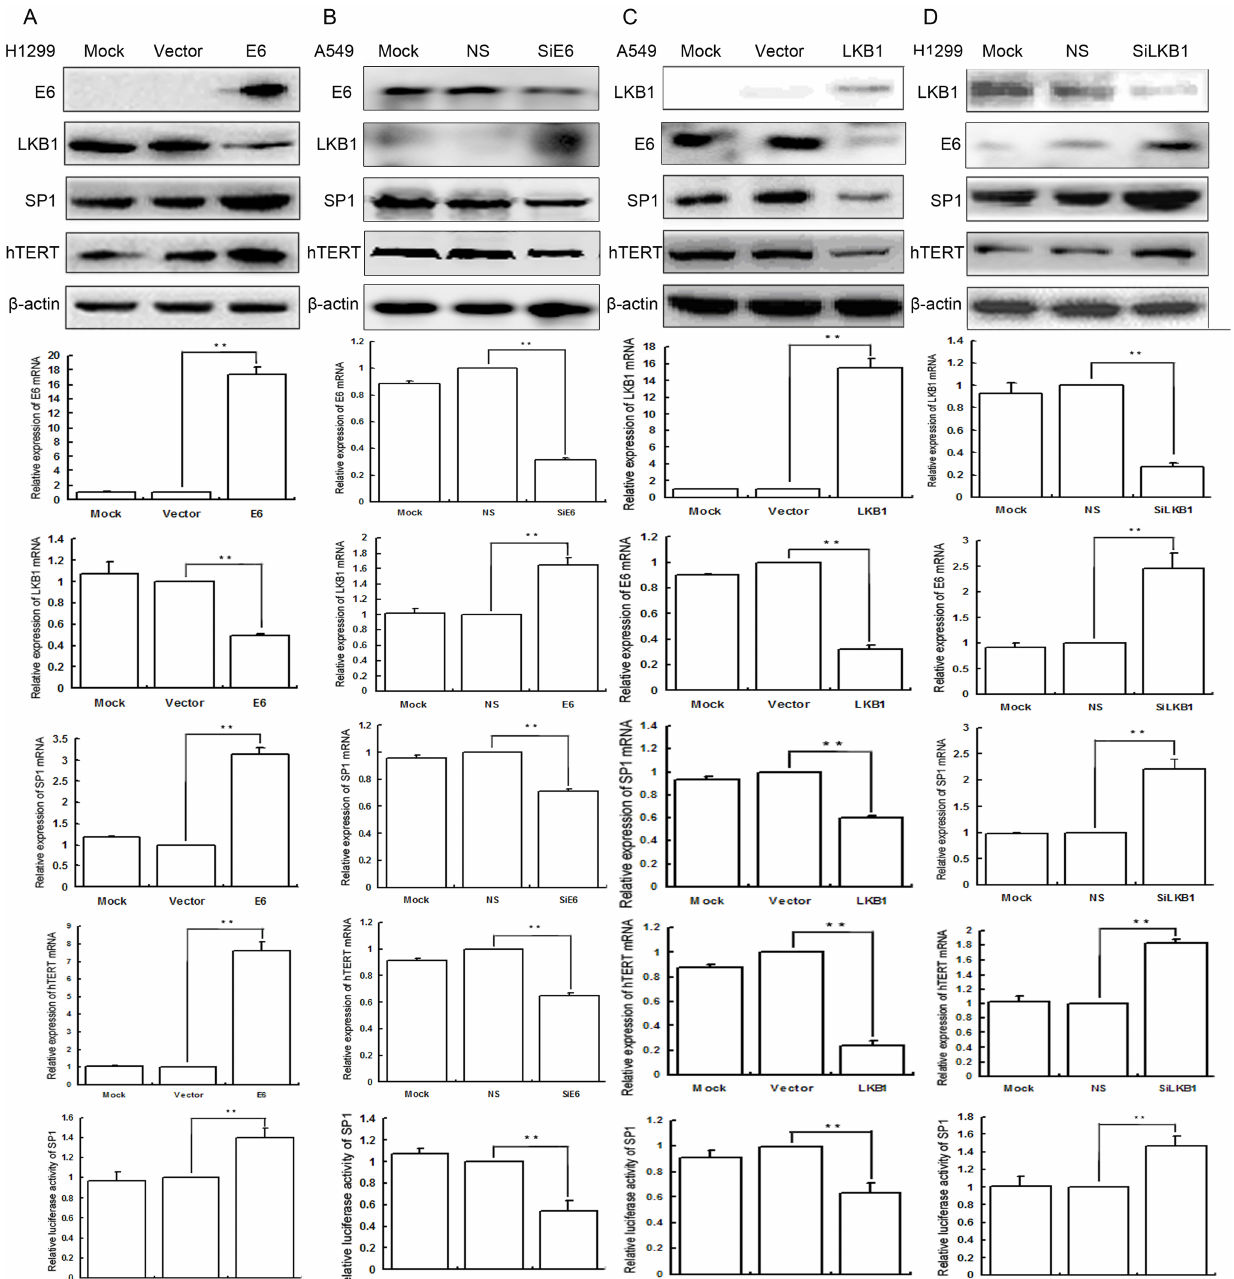
Fig 1. A Overexpression of E6, SP1, and hTERT but low expressionof LKB1 was in H1299cells. Mock mock transfection, Vector empty vector. B Low expressionof E6 SP1, and hTERT but overexpression of LKB1 was in A549 cells. Mock mock-specific siRNA; NS nonspecific siRNA, SiE6 E6-specific siRNA. C Overexpression of LKB1 but low expressionof E6, SP1, and hTERT was in A549 cells. Mock mock transfection, Vector empty vector. D Low expressionof LKB1 but overexpression of E6, SP1, and hTERT was in H1299 cells. Mock mock- specific siRNA; NS nonspecific siRNA, SiLKB1 LKB1-specificsiRNA. Detection the expressionof both protein and mRNA of E6, LKB1, SP1, and hTERT was in lung cancer cells as well as control cells by Western blot and qRT-PCR. ( ** P < 0.01). β -actinserved as internalcontrols.